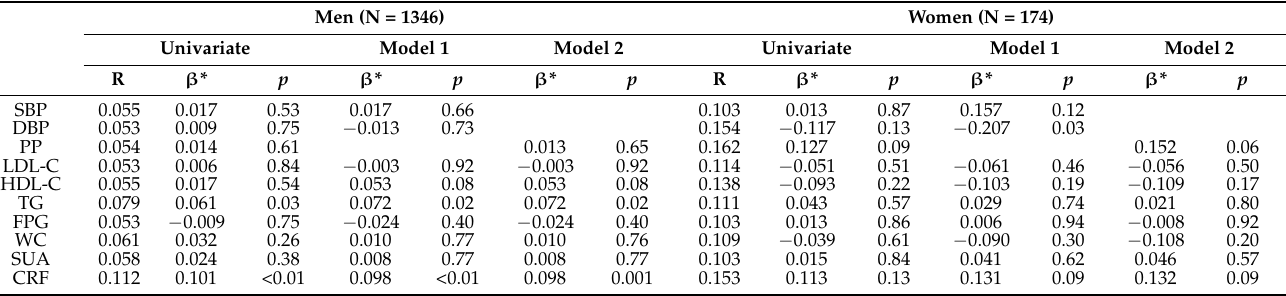
Table 3. Correlations of physical performance and cardiometabolic risk factors with carotid intima– media thickness between men and women.